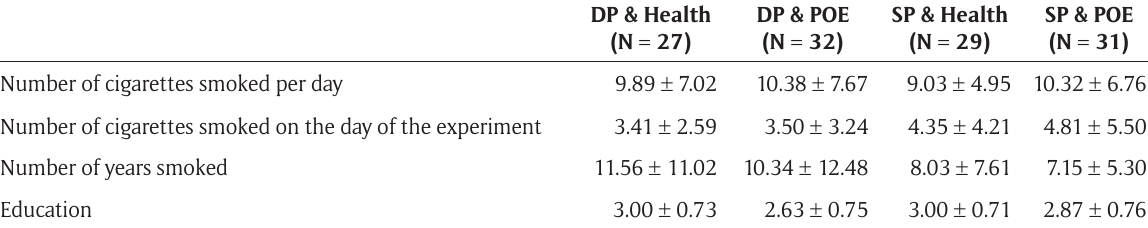
Table 1: Mean scores and standard deviations on secondary variables of Study